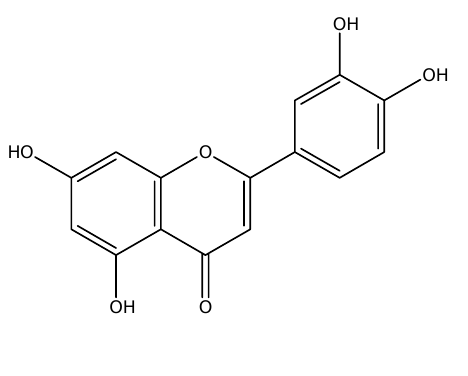
Figure 1. Chemical structure of